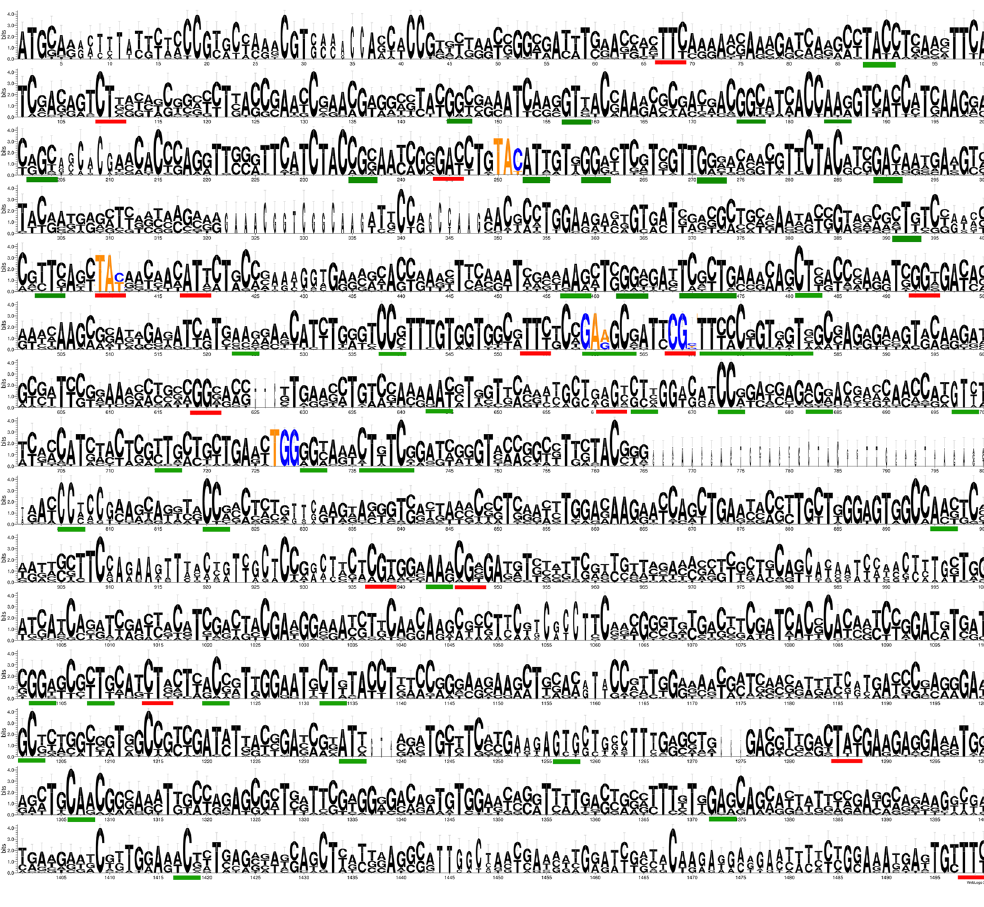
affected by HGT because of the separation of the germline from somatic cells. This barrier to HGT -known as Weismann barrier- is not present in the case of bacteria infecting germline cells as Wolbachia spp, which is con- sistent with the relatively high number of Wolbachia to insect HGT events 16 . However, no RIP encoding sequences can be found in any of the Wolbachia spp databases (including 27 fully sequenced genomes). Interestingly, HMMER searches showed hypothetical proteins harboring the RIP domain on Tenericutes class, specifically in Spiroplasma species. The fact that Spiroplasma species lack a cell wall and are frequent endosymbionts of arthro- pods makes them logical donor candidates. However, considering Spiroplasma sp. as donor involves two major drawbacks. Spiroplasma coding sequences harbor very low GC content (around 23%), whereas Culicinae RIP genes range from 39.8% to 55.6% (Table 1). Secondly, Spiroplasma spp. and some species of Millicutes use a non-universal UGA tryptophan codon. This variation in the genetic code is presumed to have occurred in the early divergence of these genera (dating 250 mya approximately) 35 while the Culicinae subfamily has diverged more recently (between 51 to 204 mya) 36, 37 . Therefore, the transferred genes containing the non-universal UGA tryptophan codons would be read as a stop. Although GC content of a transferred functional gene could be gradually modified by amelioration, the reversion of several nonsense codons to Trp does not seem plausible. Therefore, these pieces of evidence lead us to reject that Culicinae RIP genes are derived from Spiroplasma . The phylogenetically closest sequences to Culicinae RIPs belong to two cyanobacteria ( Tolypothrix bouteillei and Calothrix parietina ). Cyanobacteria constitute a significant fraction of the microbiota at breeding sites of mosquitoes. Remarkably, cyanobacterial species account for 40% of the bacterial midgut content of larval and pupal stages in An. gambiae 38 . Moreover, Calothrix sp . has been detected in the midgut bacterial flora of An. stephensi in larval stage 39 . In addition, the GC content of cyanobacterial genomes is closer to the Culicinae RIPs (Table 1). Altogether, the presented phylogenetic inferences, the shared ecological niches between these bacte- ria and insects, and the colonization of mosquitoes in their early developmental stages 38 strongly suggest that Cyanobacteria is the most plausible donor lineage of RIP genes to the subfamily Culicinae via HGT. In line with Huang 16 we postulate that Weismann barrier is, if not absent, markedly weakened in the egg, pupal, and larval